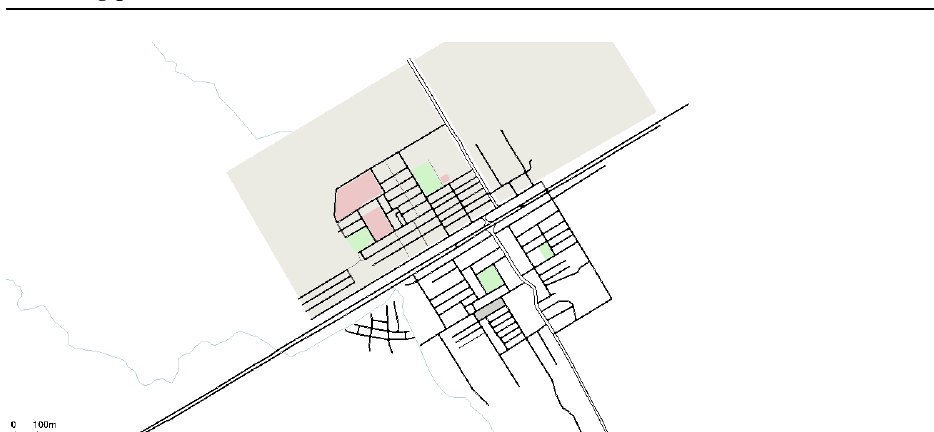
Figure 14. SUMO OpenStreet Map